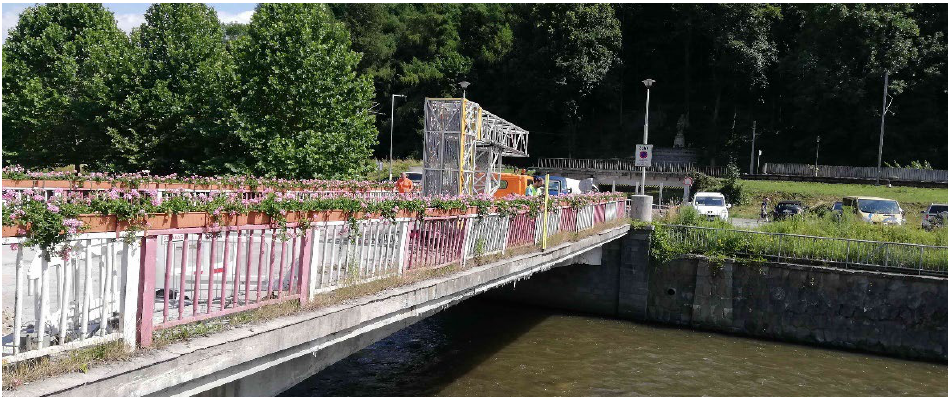
Figure 12. Geodetic Surveying—Measurement.